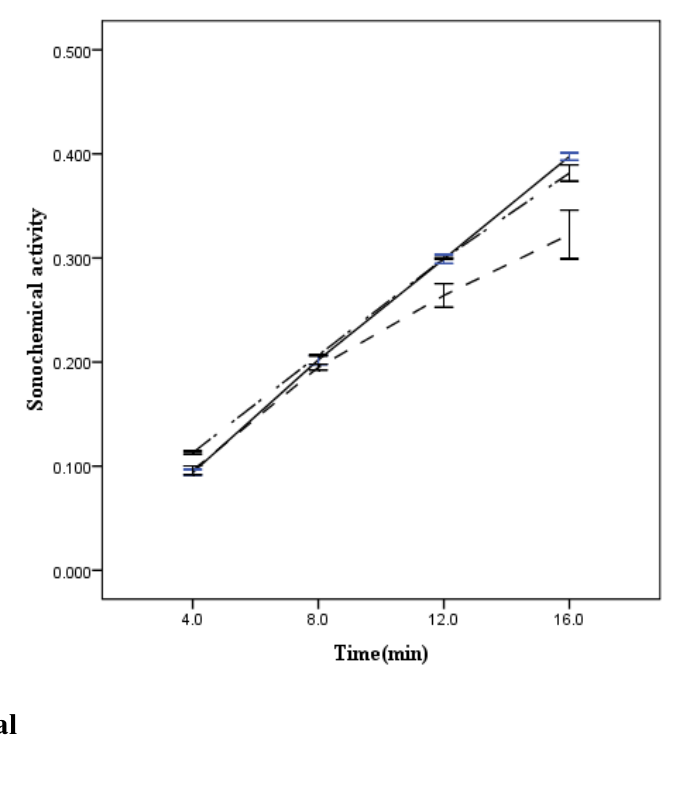
Figure 5. Influence of ultrasound treatment time on the sonochemical